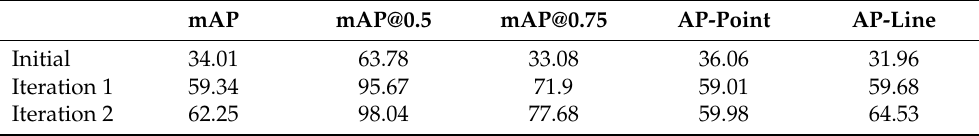
Table 3. Quantitative results before and after each re-annotation step. If not specified, AP is considered the mean average precision calculated at different IoU thresholds between 0.5 and 0.95 with a step size of